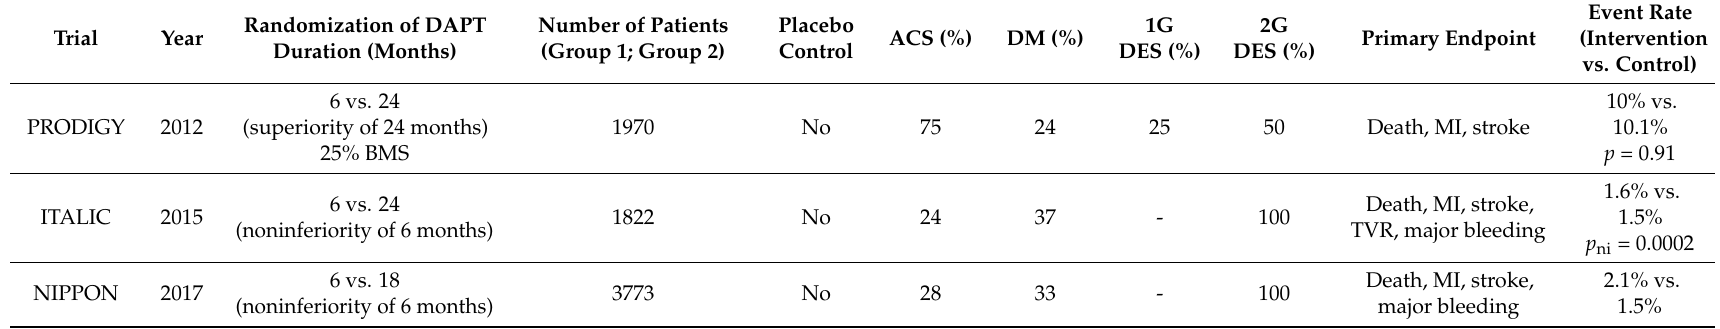
Table 4. Comparative featurmmmes of randomized controlled trials (RCTs) for short DAPT (S-DAPT) vs. long DAPT